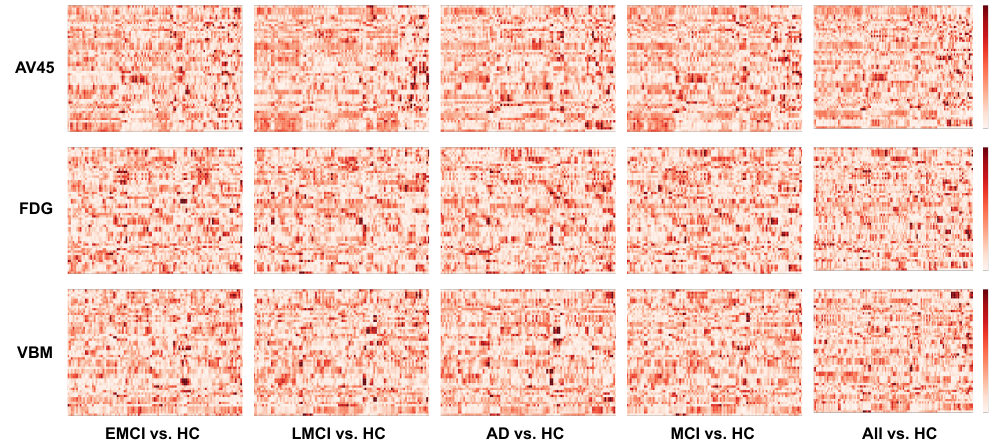
Figure 2. Detailed imaging genetic association maps (54 SNPs by 116 ROIs) with each entry as a normalized − log 10 ( p -value ) from linear regression of ROI vs. SNP within each comparison group. Normalization was performed so that each row has a squared norm of 1. The vertical axis follows the SNP order listed in Table A2. The horizontal axis follows the ROI order listed in Table